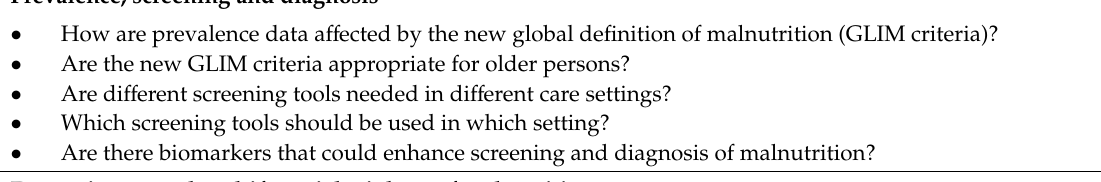
Table 2. Open questions regarding management of malnutrition in older people. Prevalence, screening and